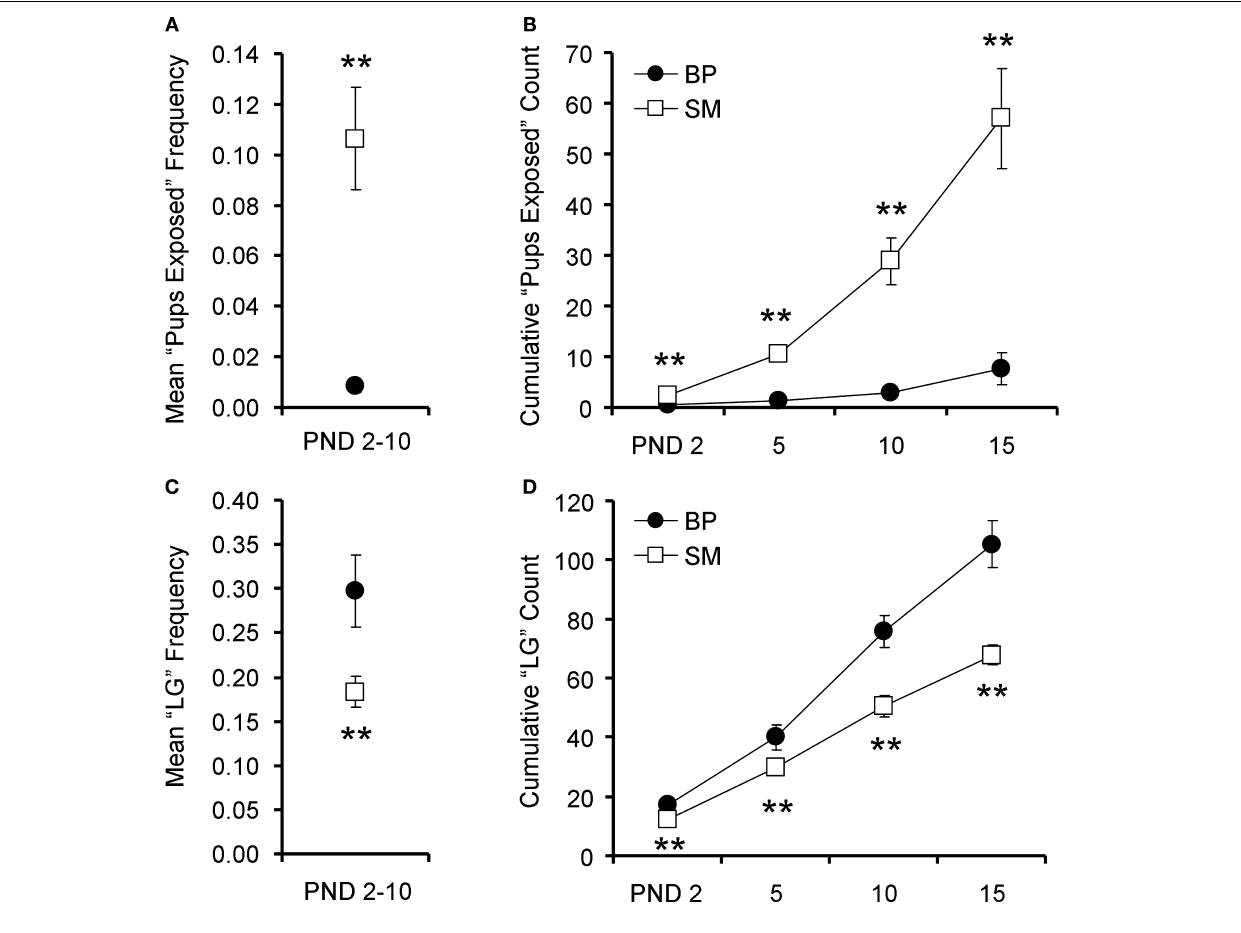
FIGURE 1 | Family unit observations. Single-mother (SM) and biparental (BP) family units were observed to examine pup care. Averaged over PND2–10, pups reared by SMs were left exposed at a higher frequency (A) and were licked and groomed (LG) at a lower frequency (C) , compared to BP-reared